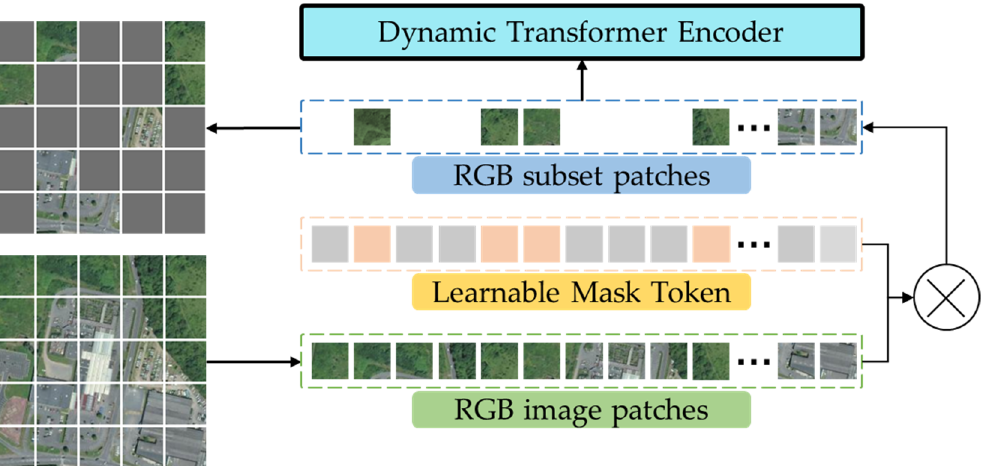
Figure 2. The architecture of the LMP model in the RGB image path. The RGB image is divided into regular non-overlapping patches, x p , and these patches are input into LMT to sample a subset of patches, x s